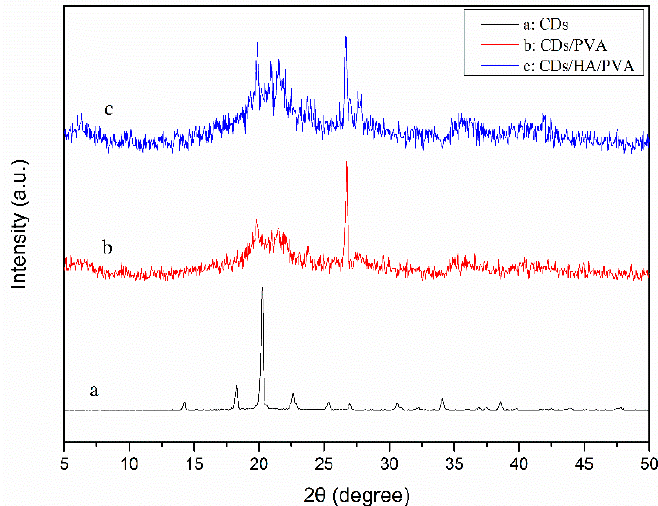
Figure 2. The XRD patterns of dried ( a ) CDs, ( b ) CDs/PVA hydrogel, and ( c ) CDs/HA/PVA